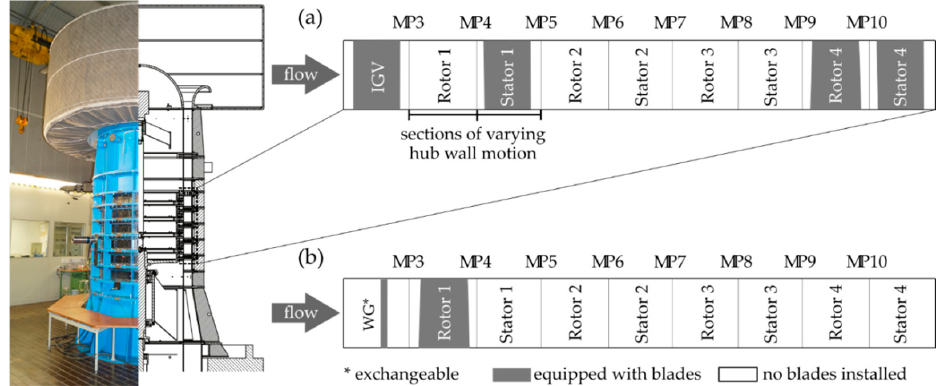
Figure 1. Low Speed Research Compressor (LSRC)—cross section of investigated setups with stator S1 ( a ) and rotor R1 ( b ).